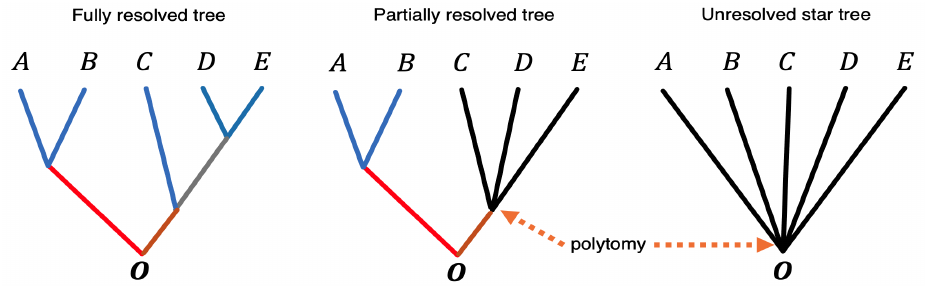
Figure 3. Tree with polytomy cases. Left panel : a fully resolved five-taxon tree (same tree in Figure 1), where any node only has two immediate descendants. Middle panel : a tree with a mixture of resolved nodes and polytomy by considering that three taxa C , D , E (60% of taxa) on the tips are independent. Right panel : a completely unresolved tree, termed a star-shaped tree (100% polytomy), where all taxa are